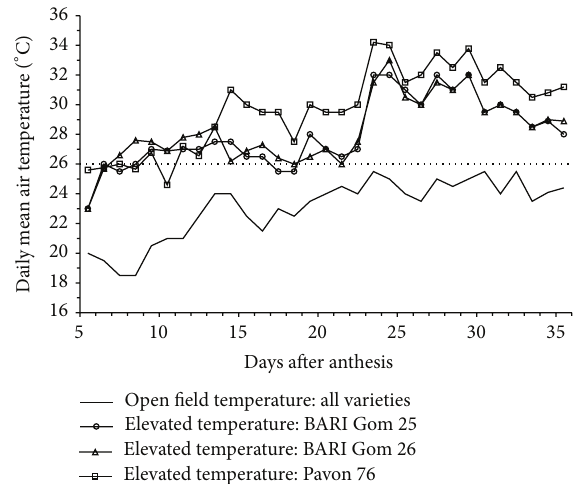
Figure 1: Daily mean air temperature received by three wheat culti- vars from 5 to 35 DAA under open field and elevated temperature conditions. Horizontal dotted line indicates the critical level of temperature for grain growth of